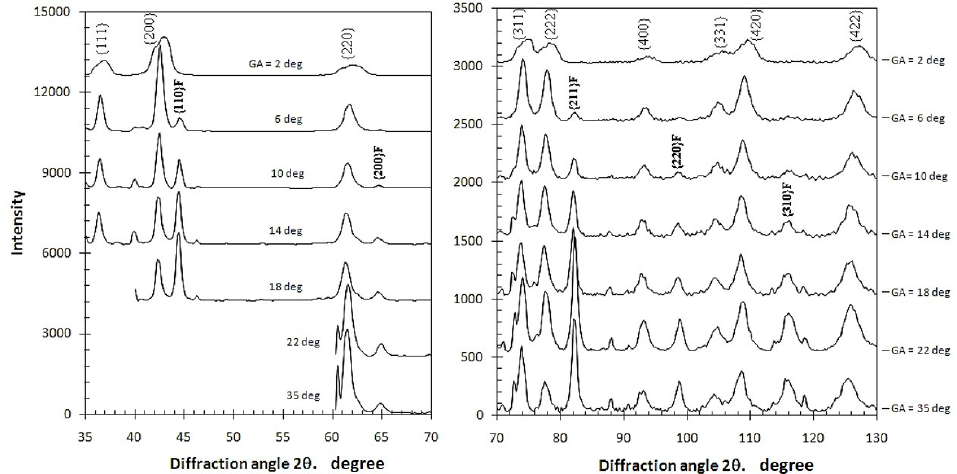
Figure 3. Diffraction curves acquired at various Ω angles (GA refers to glancing angle Ω ). Table 2. The measured peak positions, 2 θ , of the TiN crystalline planes from {111} to {422} at various incident Ω angles (degree).